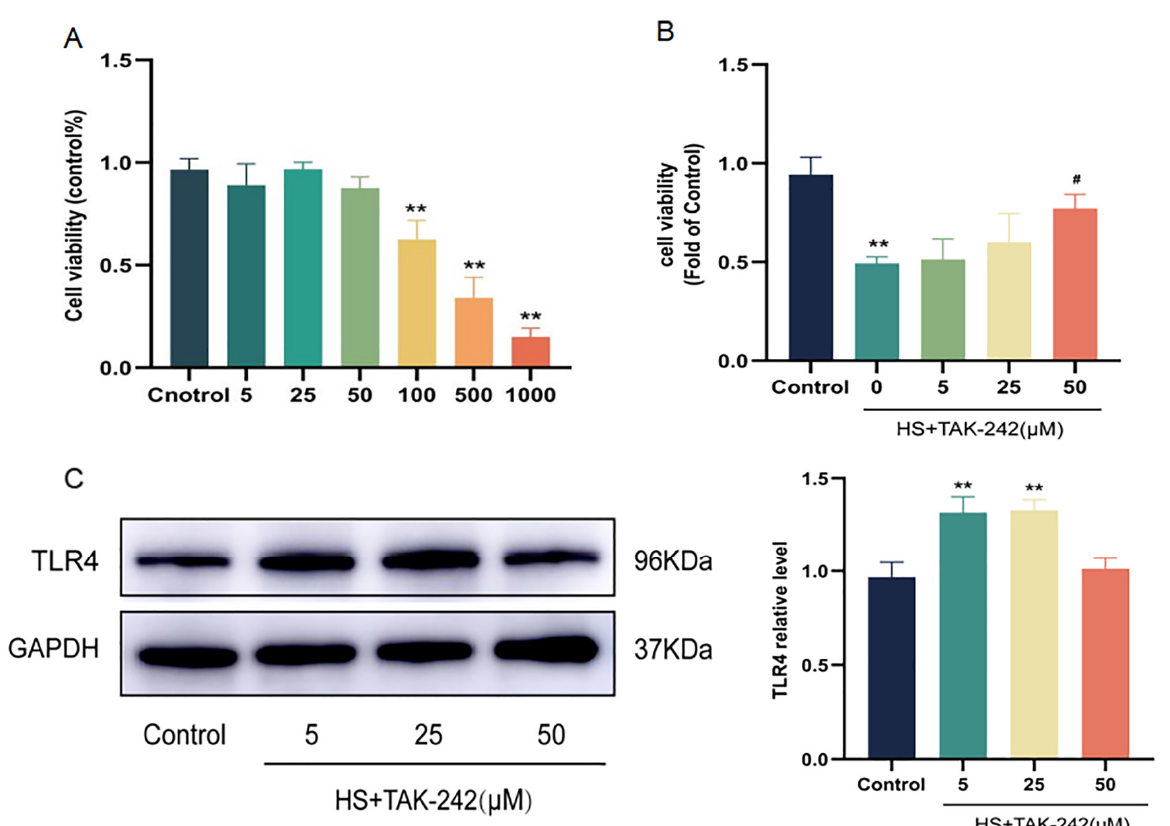
Figure 4. Effects of TAK-242 pretreatment on H9C2 cell viability and TLR4 expression level. Effect of different concentrations of TAK-242 on H9C2 cell viability ( A ). Effect of low concentration TAK-242 on H9C2 cell viability after heat exposure ( B ). Effect of low concentration of TAK-242 on TLR4 expression in H9C2 cells after heat exposure ( C ). The results were expressed as the mean ± SD deviation of three independent experiments, ** p < 0.01 vs. the control group; # p < 0.05 vs. the HS group.